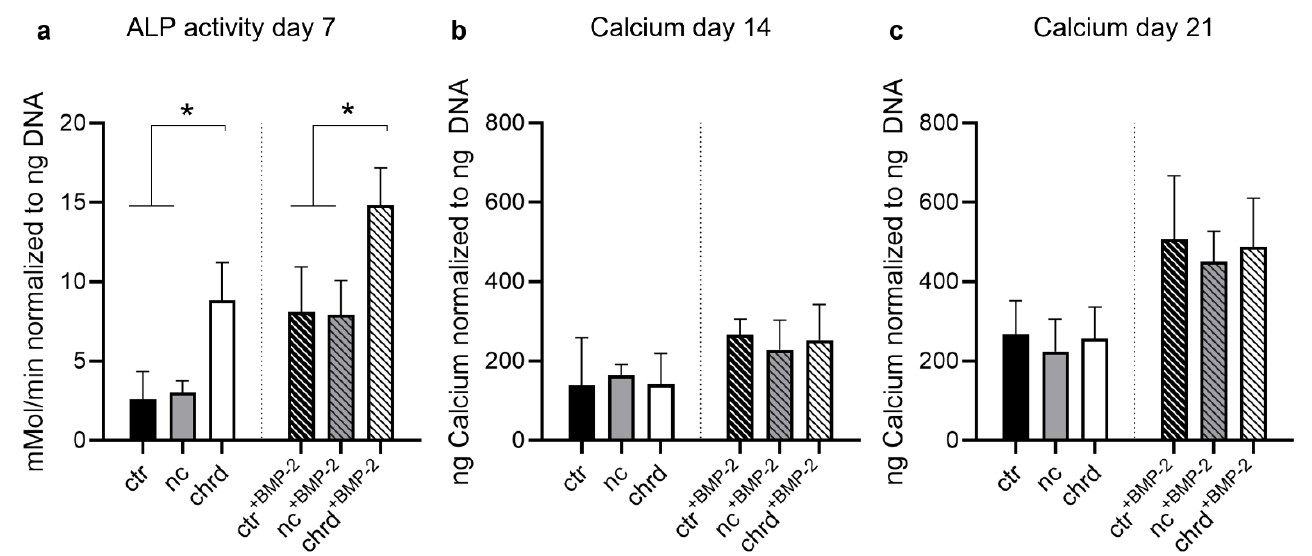
Figure 2. ( a ) ALP activity after 7 days, and mineralization after ( b ) 14 and ( c ) 21 in microtissues assembled from siRNA-loaded cGM and hMSC cultured in osteogenic medium with or without BMP-2 (ctr: non-treated control, nc: non-coding siRNA, chrd: chordin siRNA). Statistically significant differences ( p < 0.05) are indicated with (*).